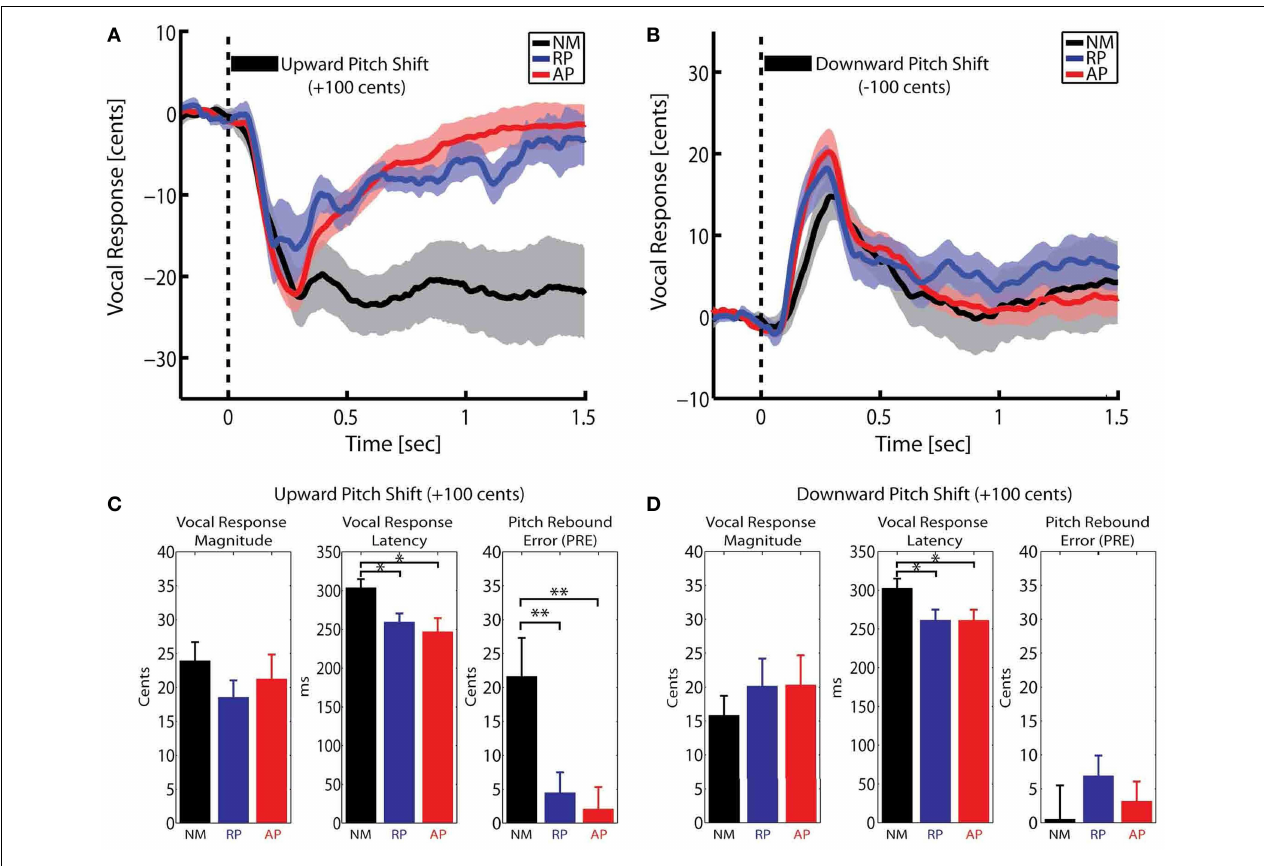
FIGURE 1 | Overlaid time course of the compensatory vocal responses to (A) upward and (B) downward pitch shift stimuli across three groups of non-musicians (NM) and relative pitch (RP) and